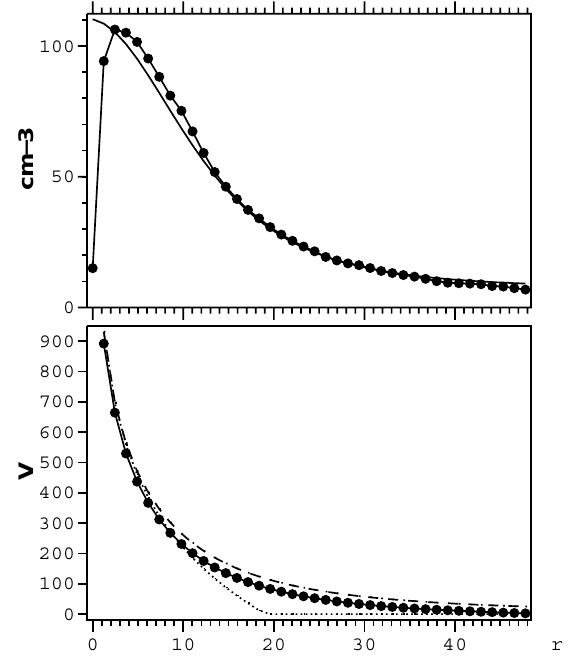
Fig. 2. 1-D plasma simulation results. Upper panel: Radial pro- file of electron density from simulation (dot-marked line), model density Eq. (4) (solid line). Lower panel: Simulated potential (dot- marked line), model potential Eq. (2) (dashed line), vacuum poten- tial Eq. (1) (dotted line). Negative values of the vacuum potential have been replaced with